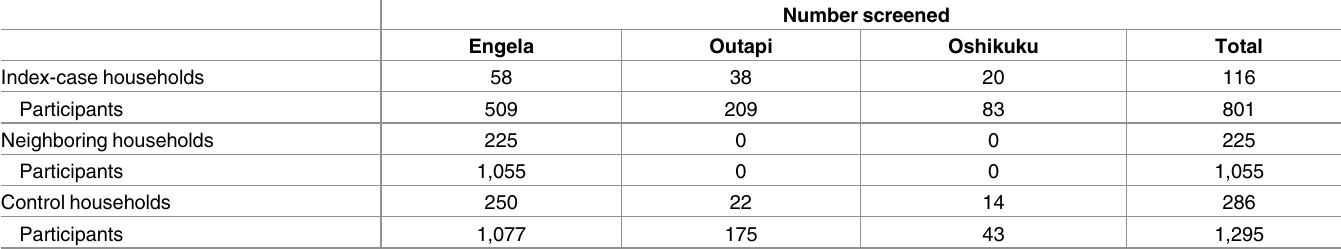
Table 1. Number of participants screenedin case, neighboring and control households in Engela, Outapi and Oshikuku health districts.